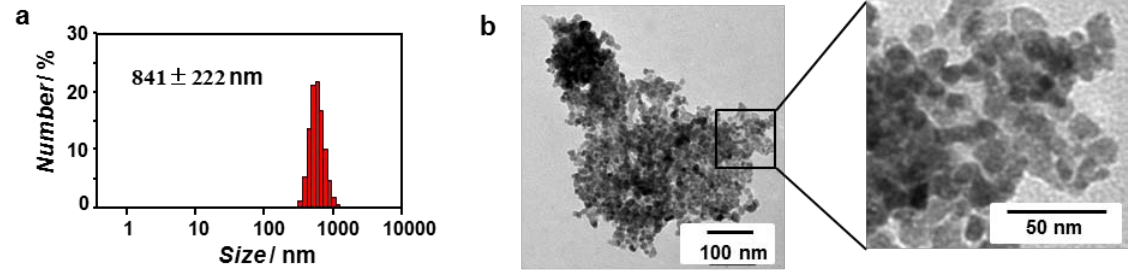
Figure 4. Size distribution obtained from ( a ) DLS and ( b ) unstained TEM image of ZnO nanoparticles ([ZnO] = 0.1 mM) in 10 mM Tris-HCl buffer (pH 7.4) at 25